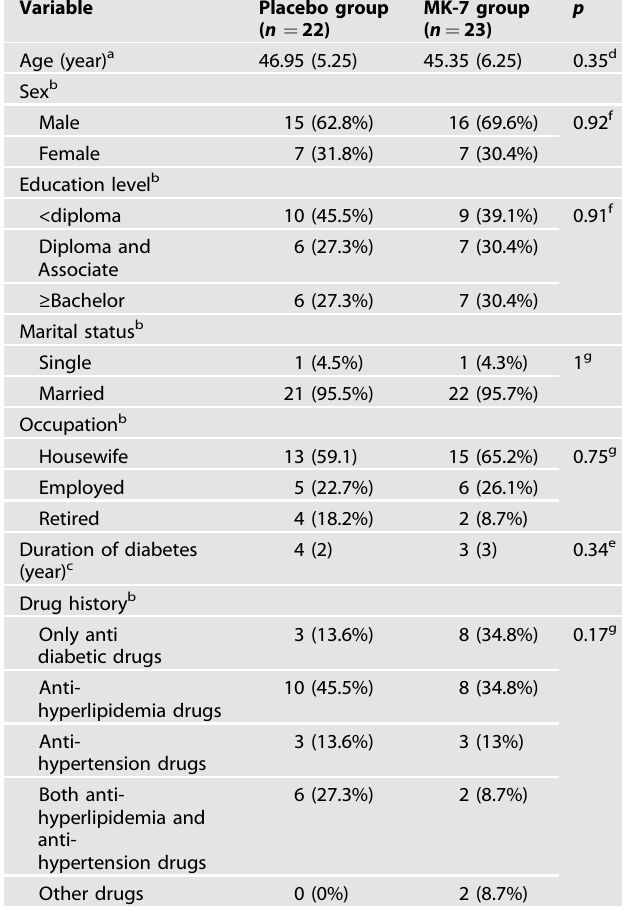
Table 1. Baseline characteristics of the study